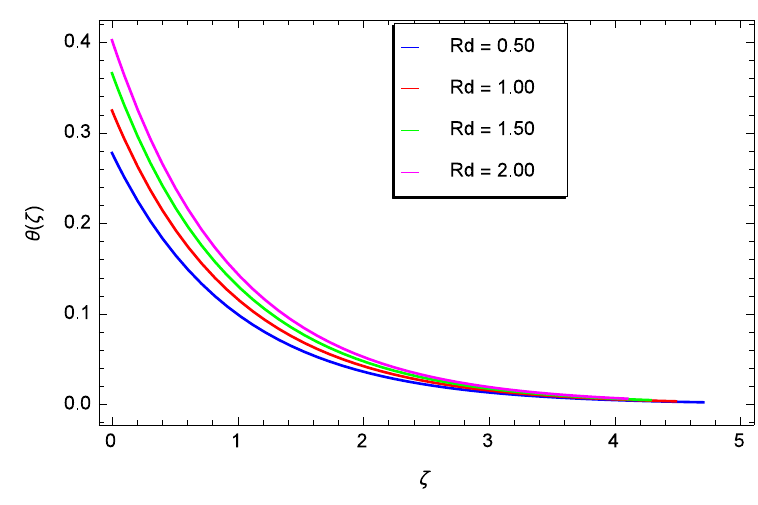
Figure 12. Influence of Rd on θ ( ζ ) .